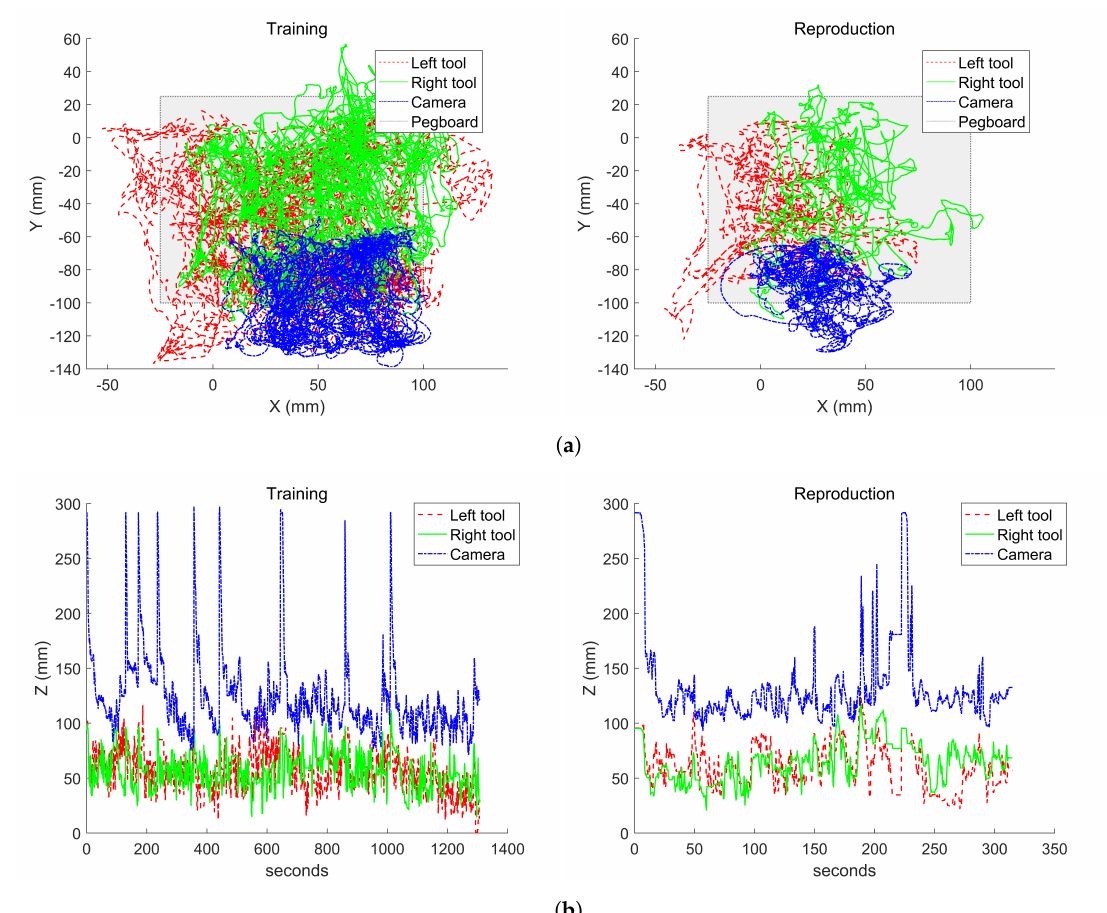
Figure 9. Comparison between the training and the reproduction experiments for the instruments tracking behavior: ( a ) tracking of the instruments in the horizontal plane, and ( b ) tracking in the vertical plane.